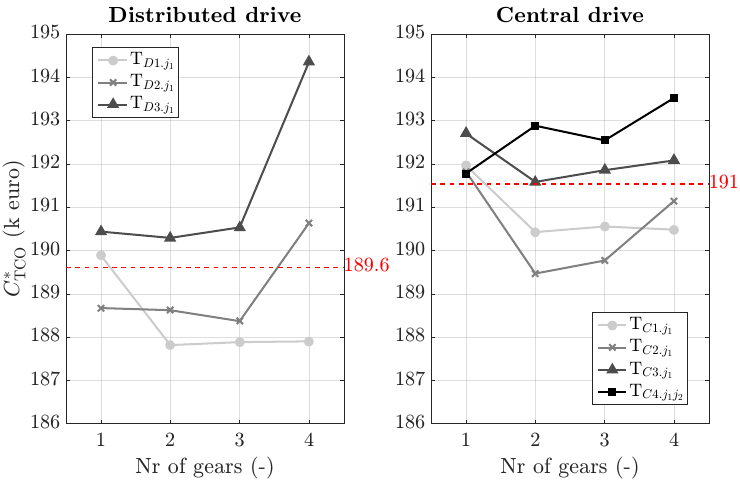
Figure 8. The optimal total-cost-of-ownership ( C ∗ ) versus the number of gears in the gearbox. TCO The results are grouped with on the left the distributed configurations and on the right the central drive configurations. The results belonging to the same topology are connected with lines. The red dotted lines and the red number indicate the average total-cost-of-ownership for each of the two